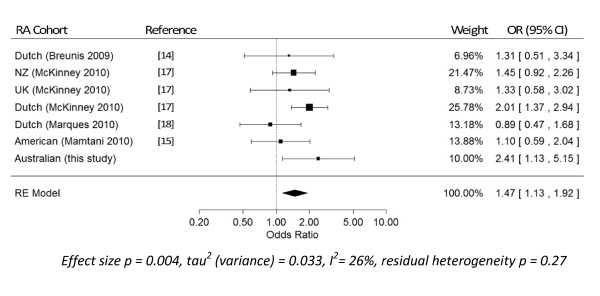
Association of low Fc gamma receptor 3B copy number with rheumatoid arthritis. Random effects (RE) meta-analysis of the association of low Fc gamma receptor 3B (FCGR3B) copy number (CN < 2) versus FCGR3B CN ≥ 2 with rheumatoid arthritis (RA). CI, confidence interval; NZ, New Zealand; OR, odds ratio.